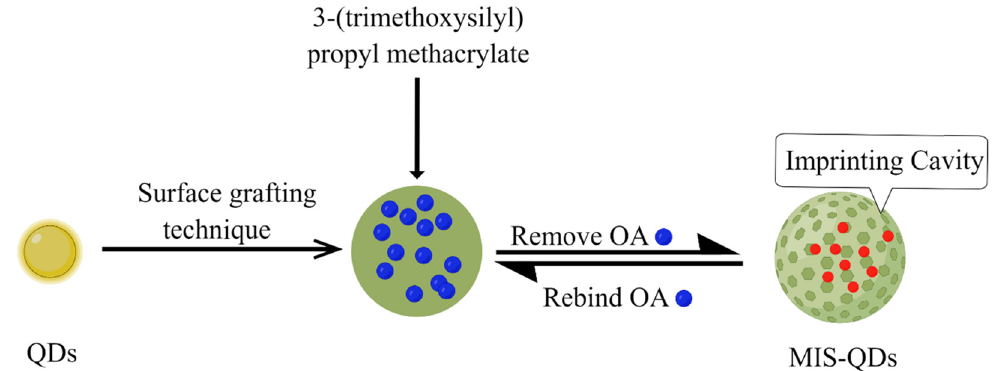
Figure 1: Scheme of the microplate assay based on MIS - QDs for OA